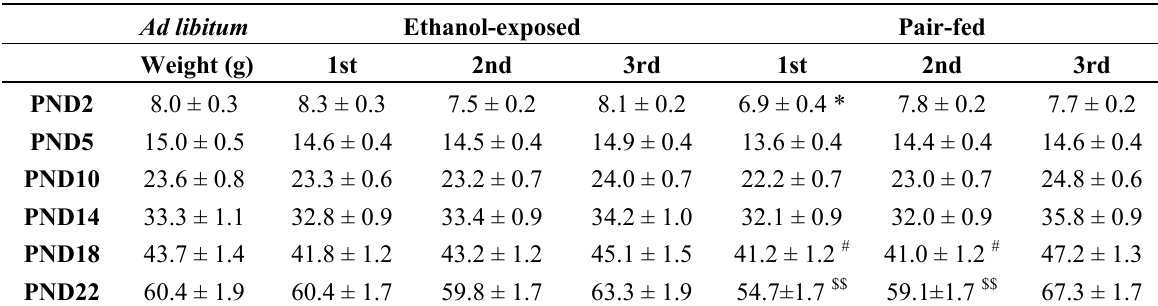
Table 2. Effect of perinatal ethanol exposure on offspring body weight. A repeated measures ANOVA revealed that there was no significant effect of sex and therefore data from both males and females were combined. A significant main effect of perinatal condition was observed (see text for statistical details). Results are expressed as means ± SEM. Results are considered statistically significant if p < 0.05. * p < 0.05 compared to ad libitum controls and 1st trimester ethanol exposed animals (postnatal day (PND) 2). # p < 0.05 compared to 3rd trimester pair-fed animals (PND 18). $$ p < 0.01 compared to 3rd trimester pair-fed animals (PND